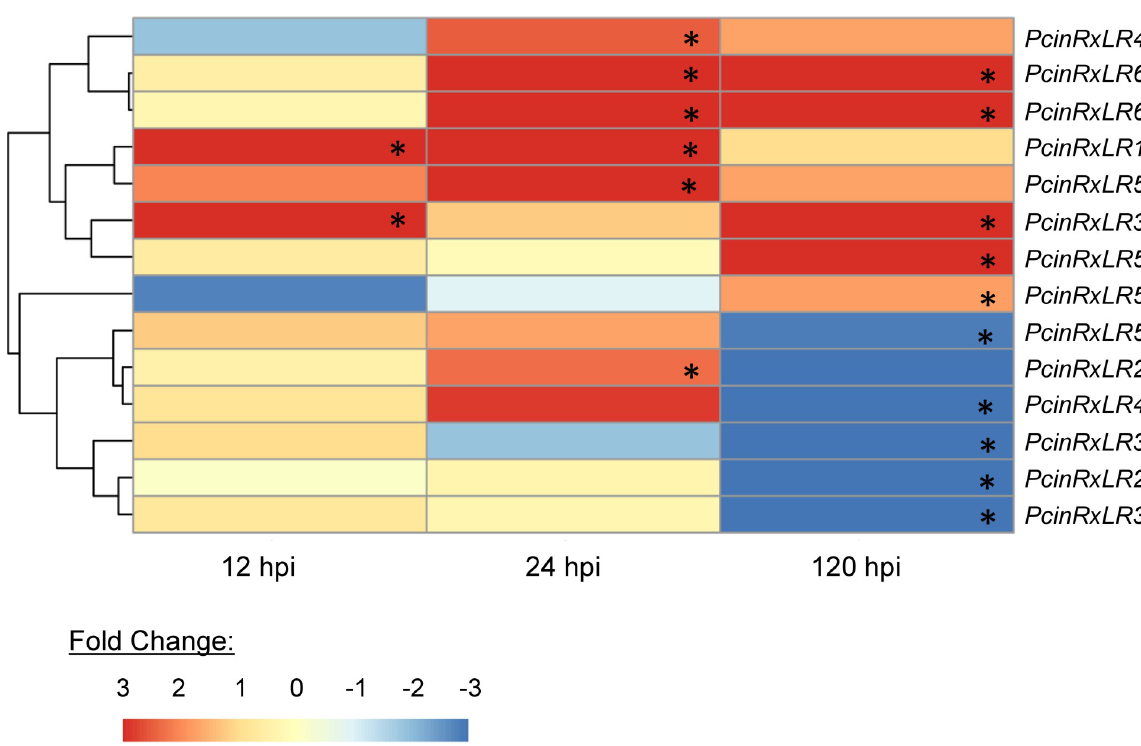
Fig 3. Expression profiles of 14 significantly expressed Phytophthora cinnamomi candidate RxLR s in infected avocado. Gene expression was visually represented in a heatmap based on read counts generated from dual RNA-Seq data. Expression levels are indicated as fold change of each gene normalized against expression in mycelia, and colour-coded according to the corresponding scale. Expression profiles were generated using RNA-Seq data obtained for three biological replicates of a susceptible avocado rootstock, R0.12, harvested at 12 hours-, 24 hours- and 120 hours post inoculation (hpi). Statistical significance was determined according to DESeq2 outputs, and is indicated on colour blocks for fold change relative to mycelia at relevant timepoints for each gene. � Significant expression at time-point relative to expression in mycelia at p � 0.05.